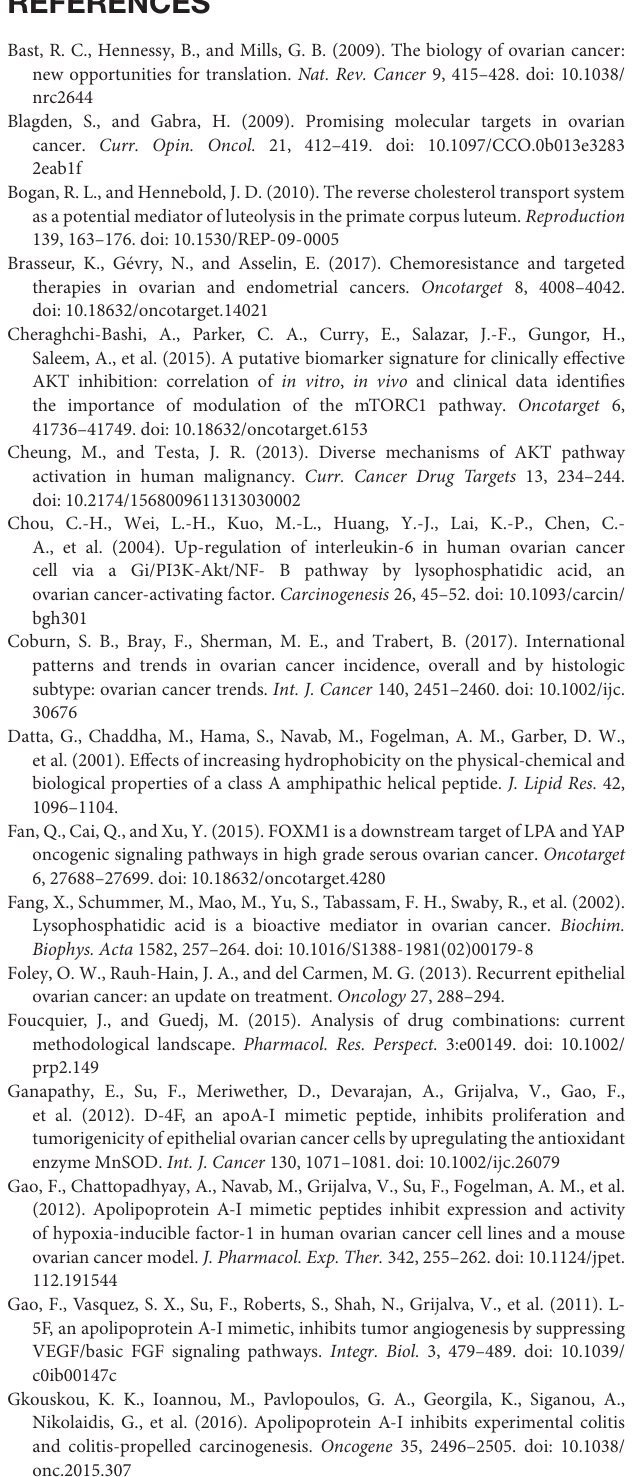
control. Cell lysates were collected 12 or 24 h after treatment and subjected to western blot analysis. Calnexin was employed as the loading control. (A) Densitometry for Pan Akt; (B) densitometry for total